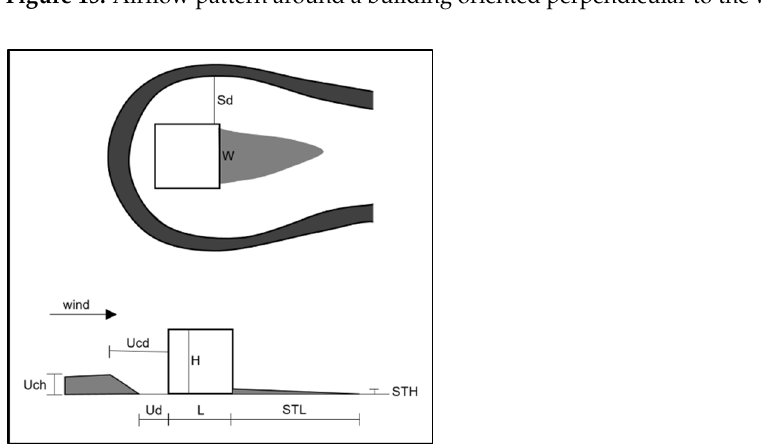
Figure 15. Airflow pattern around a building oriented perpendicular to the wind.